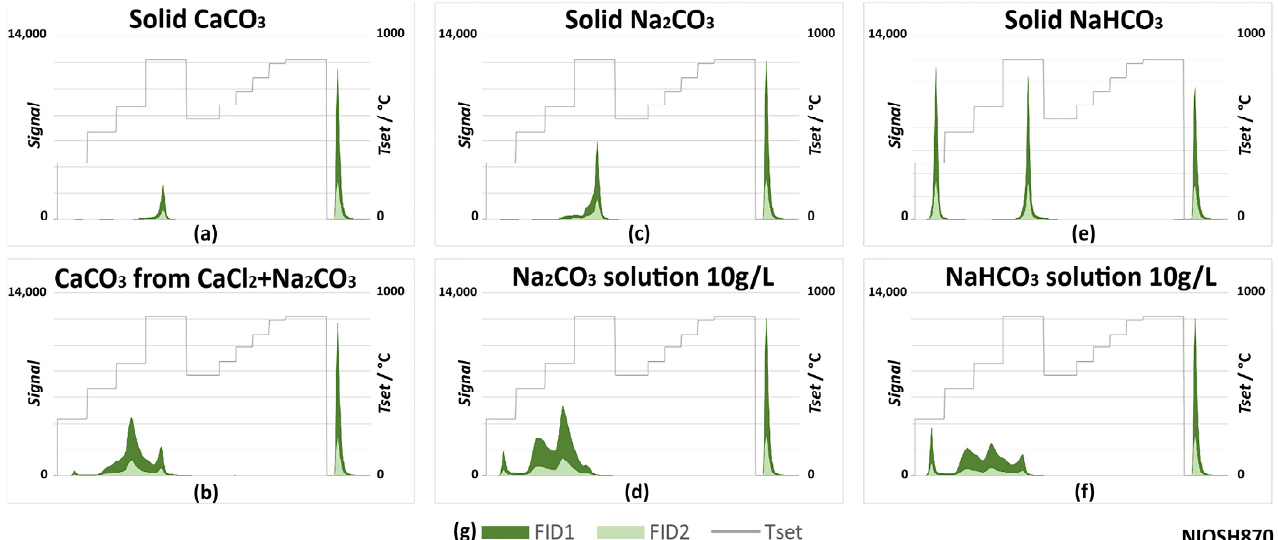
Figure 10. Carbonates’ behaviors with the NIOSH870 TOT protocol: thermograms ( a ) for calcium carbonate; ( b ) for calcium carbonate obtained by precipitation from aqueous solution; ( c ) for solid sodium carbonate; ( d ) for sodium carbonate by deposition from solution; ( e ) for sodium bicarbonate; ( f ) for sodium bicarbonate by deposition from solution; ( g ) legend for all graphs.